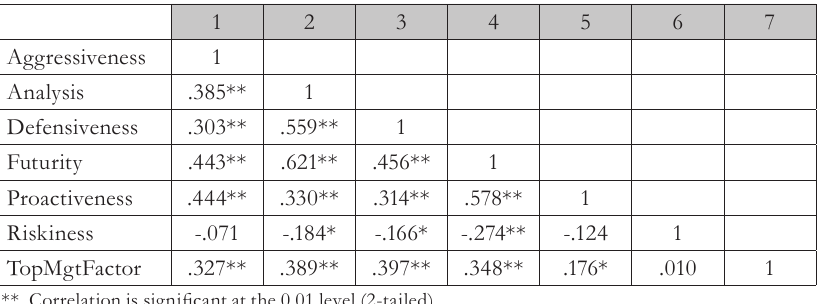
Tab. 2 - Zero-Order Correlation Co-efficient of Top Management Factor and Strategic Orienta- tion Dimension. Source: Field Survey.